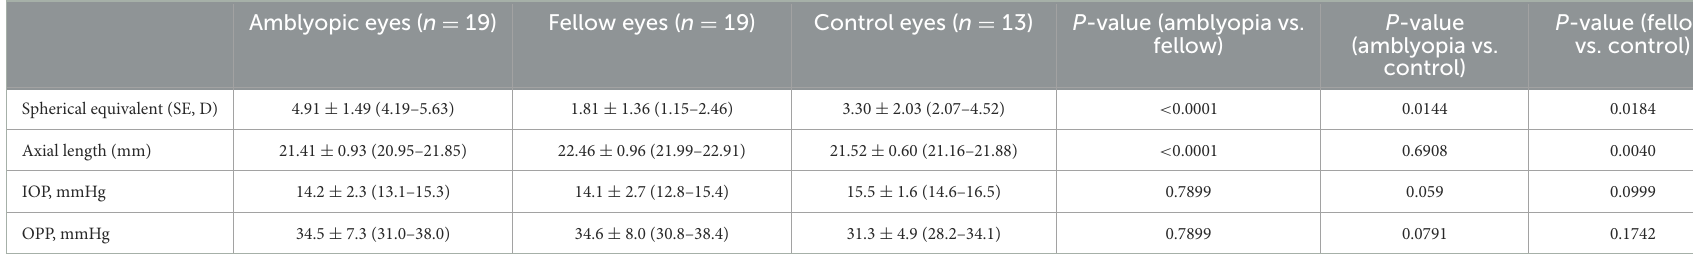
TABLE 2 Comparison of the SE, axial length, IOP, and OPP values among the amblyopic, fellow, and control eyes.